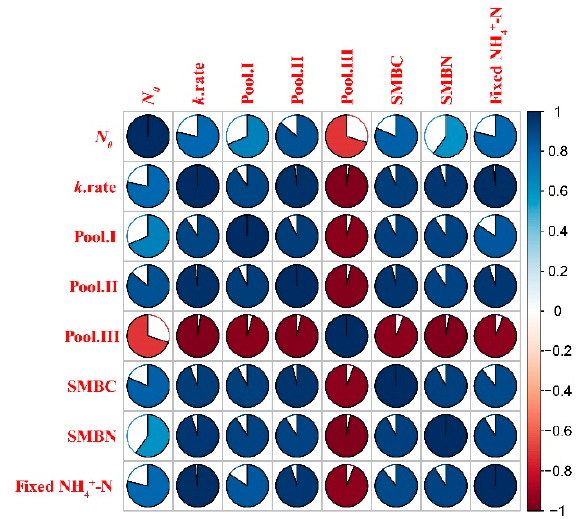
Figure 7. Pearson’s correlation matrix between N mineralization rate, N pools, microbial biomass and fixed NH 4+ . A graphical representation of the Pearson correlation matrix for the initial features. Blue and red colors indicate positive and negative correlations, respectively. The lighter the tone used, the less significant the corresponding correlation. The filled fraction of the circle in each of the pie charts corresponds to the absolute value of the associated Pearson correlations coefficient. (For interpretation of the references to color in this figure legend, the reader is referred to the web version of this article.)